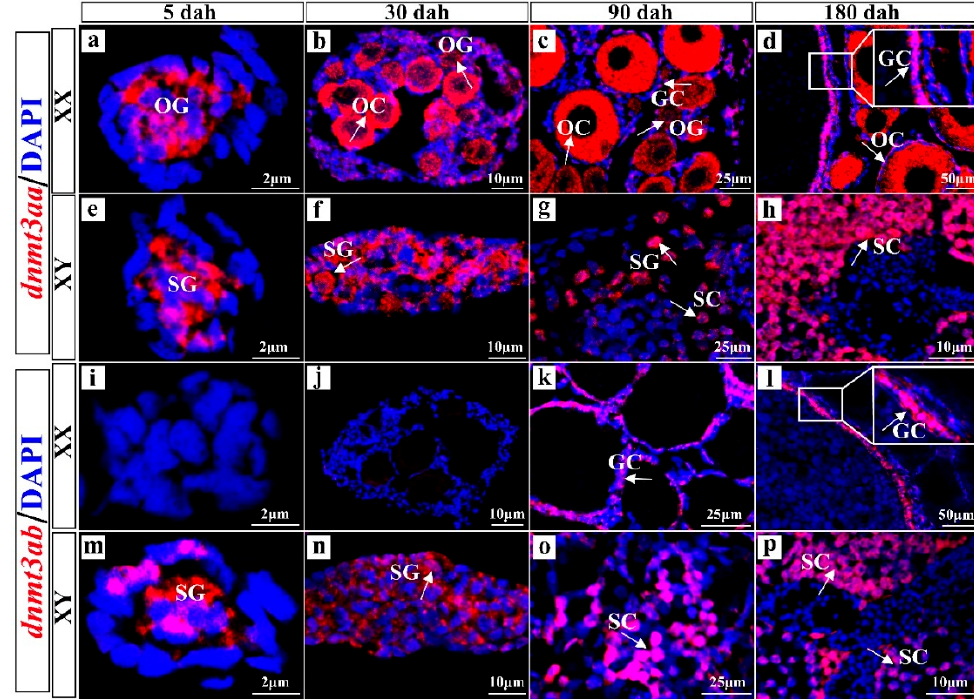
Figure 1. Cellular localization of dnmt3aa ( a – h ) and dnmt3ab ( i – p ) in developing gonads by fluores- cence in situ hybridization. Dnmt3aa was widely expressed in the gonads of Nile tilapia, especially in oogonia, phase I and II oocytes and granulosa cells of ovaries ( a – d ) and spermatogonia and spermatocytes of testes ( e – h ). Dnmt3ab was mainly expressed in granulosa cells of ovaries ( i – l ) and spermatocytes of testes ( m – p ). OC, oocytes; OG, oogonia; GC, granulosa cells; SC, spermatocytes; SG, spermatogonia; dah, days after hatching. Red fluorescence represents the dnmt3aa and dnmt3ab signals. Blue fluorescence represents the DAPI signals. Arrows indicate the positive signals. White boxes indicate the regions magnified in ( d ) and ( i ).